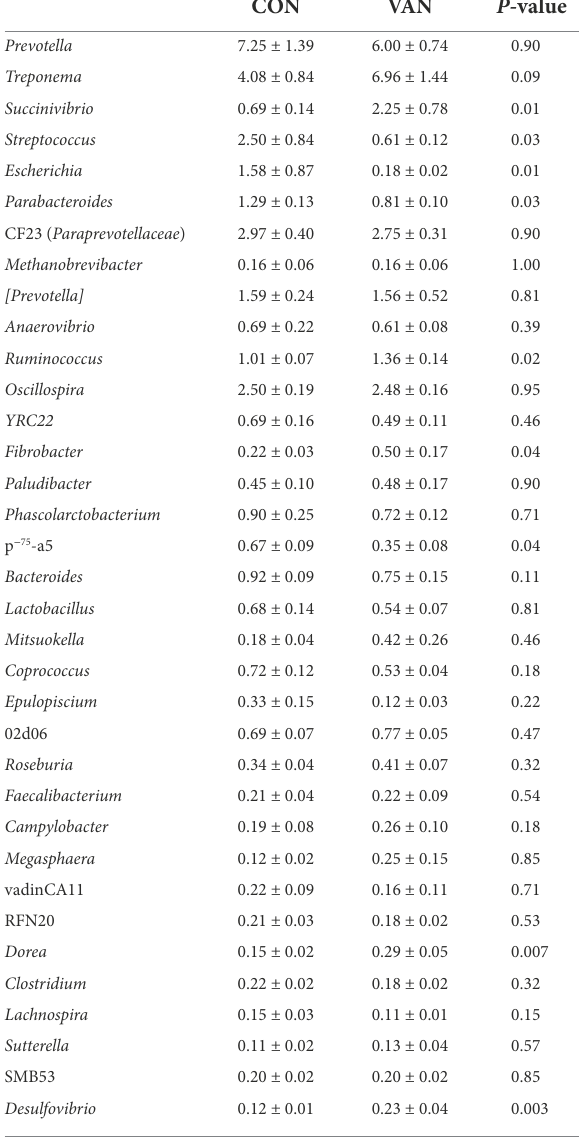
TABLE 6 The relative abundance of microflora (top 35) at genera level between CON and VAN group at day 105 of gestation (%). CON VAN P